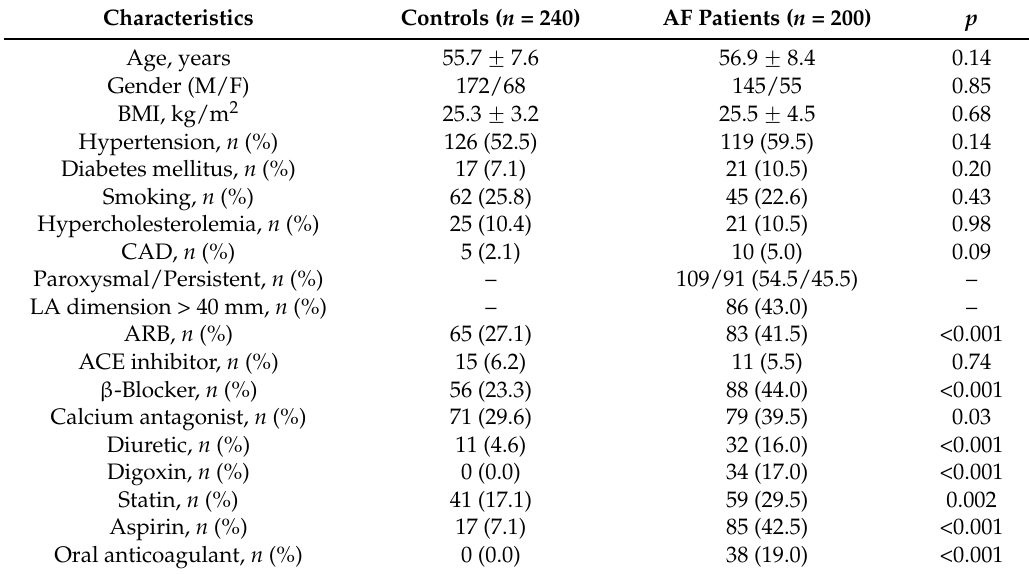
Table 1. Demographic and clinical characteristics of the study population.